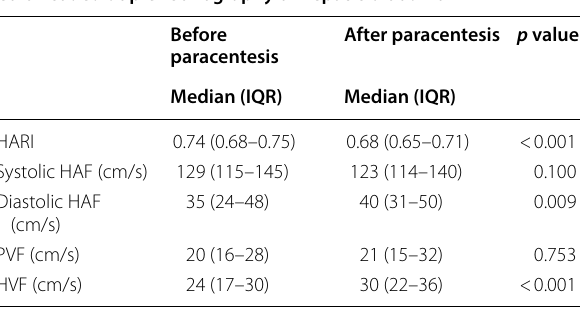
Table 4 Ultrasound examination of hepatic blood flow by color-coded duplex sonography of hepatic artery, portal vein and hepatic vein before and after paracentesis